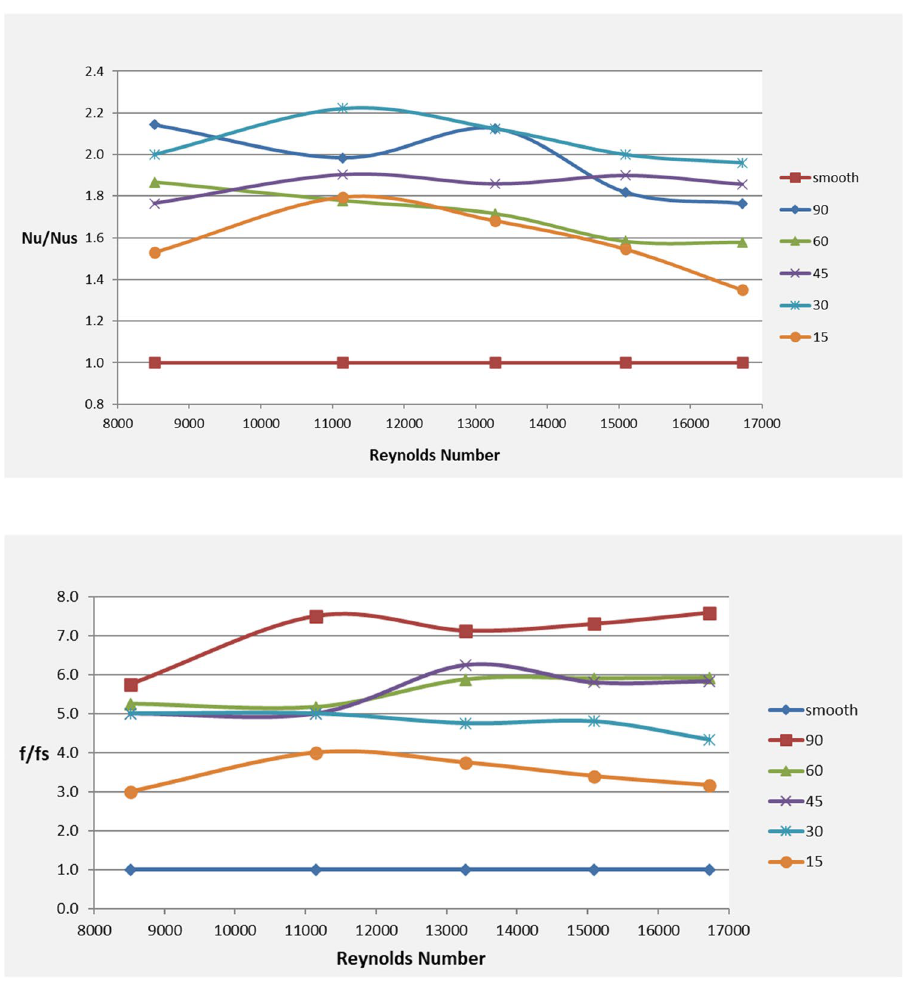
Fig. 5 Variation of Nu/Nus with Reynolds Number at P/D = 3